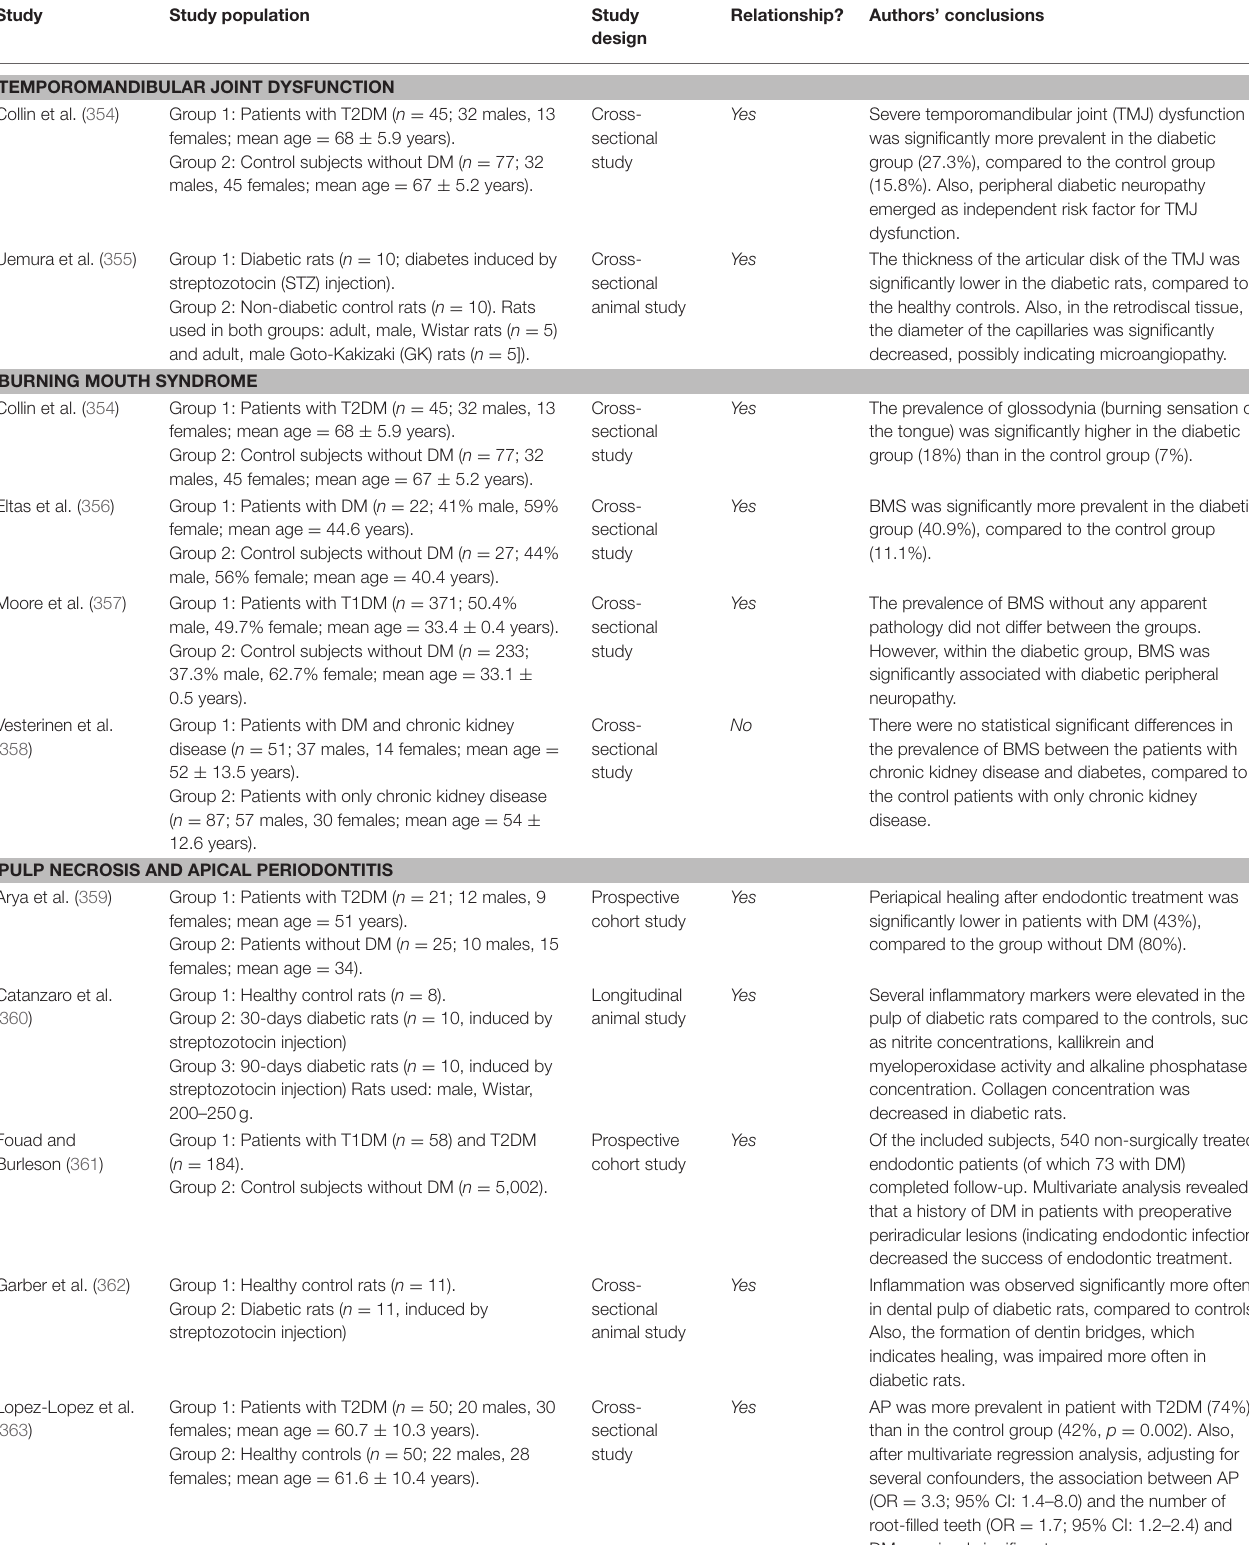
Relationship? design